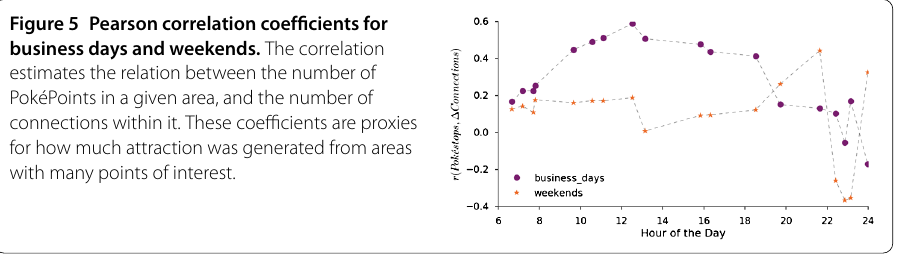
Figure 5 Pearson correlation coefficients for business days and weekends. The correlation estimates the relation between the number of PokéPoints in a given area, and the number of connections within it. These coefficients are proxies for how much attraction was generated from areas with many points of